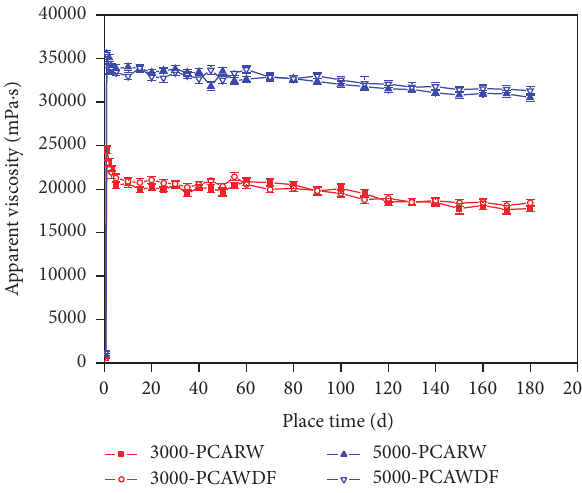
Figure 8: The viscosity modulus and elastic modulus versus scan- ning frequency curves of the profile control